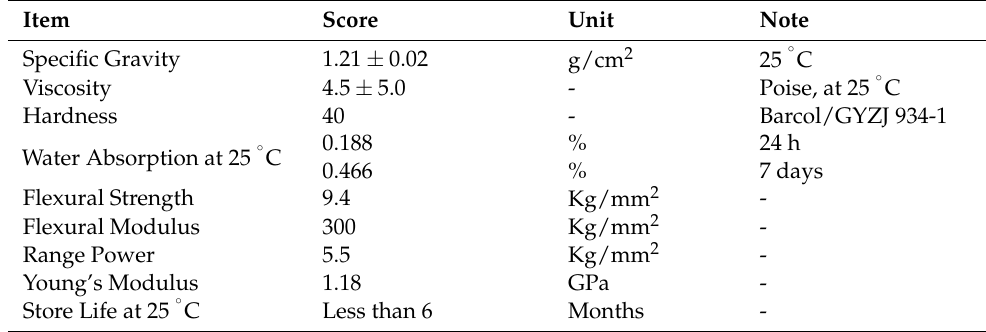
Table 1. The material properties of epoxy resin type BQTN-EX 157.